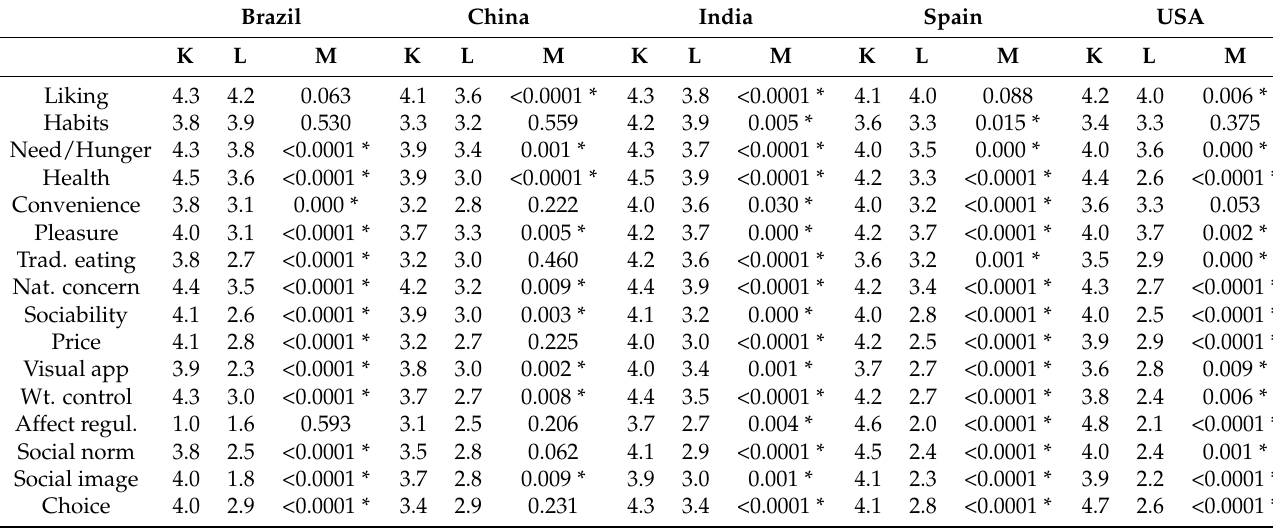
Table 4. Mean scores 1 for RATA and RATING survey formats and p -values for the corresponding two-sample t -test for each motivation construct for protein-rich foods in all five